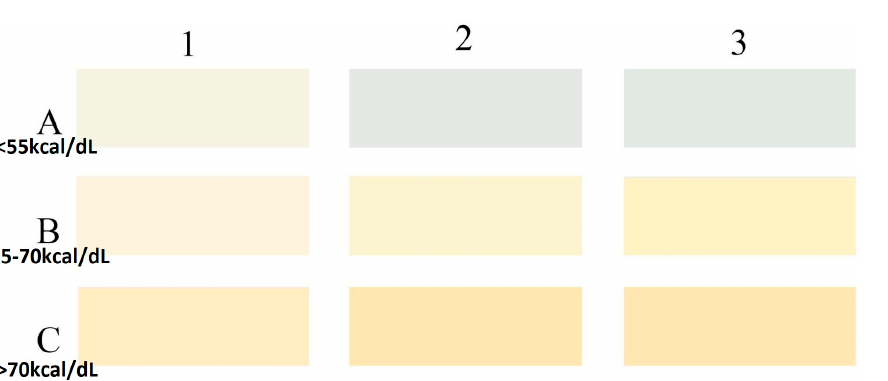
Figure 1. Preliminary HMCG tool comprising 12 shades (December 2018 version). The lighter ‘watery’ shades are grouped in the fi rst row (row A ), the ‘regular white’ appearing shades in the second row (row B ), and the ‘creamy yellow’ appearing shades are in the third row (row C ). Based on preliminary analysis (104 milk samples), certain shades that did not match